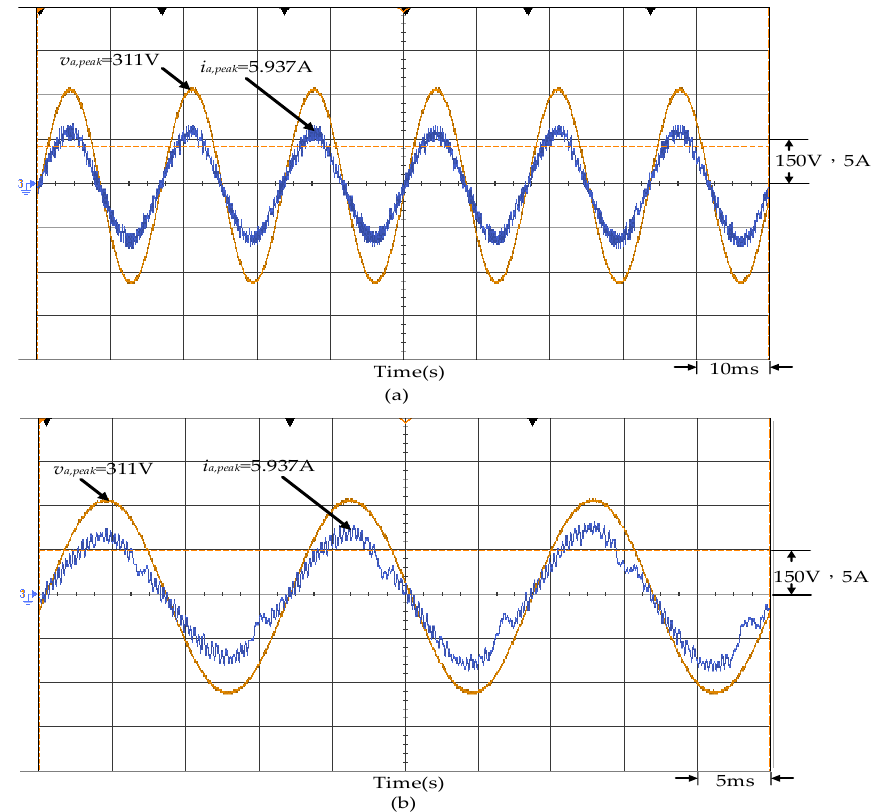
Figure 20. When the per-unit value of mains voltage in smart inverter under Phase a was between 0.97p.u. and 1.p.u.: ( a ) output voltage and current waveforms under the actual test; ( b ) partial waveform enlargement of Figure ( a ).